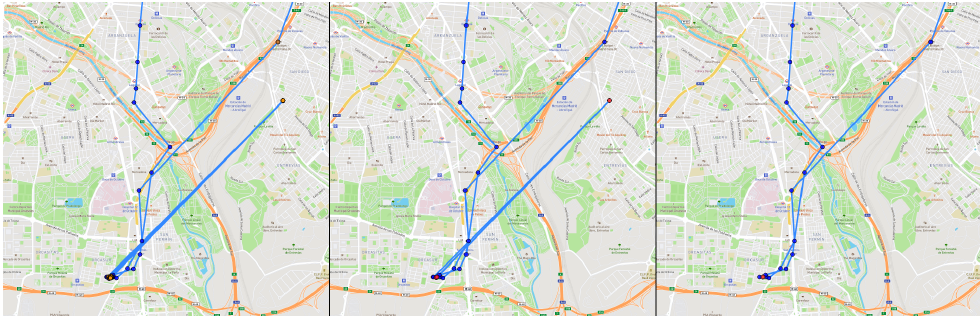
Figure 9. Zig-zag shaped static drift. Raw ( left ), first iteration ( center ), second iteration ( right ).